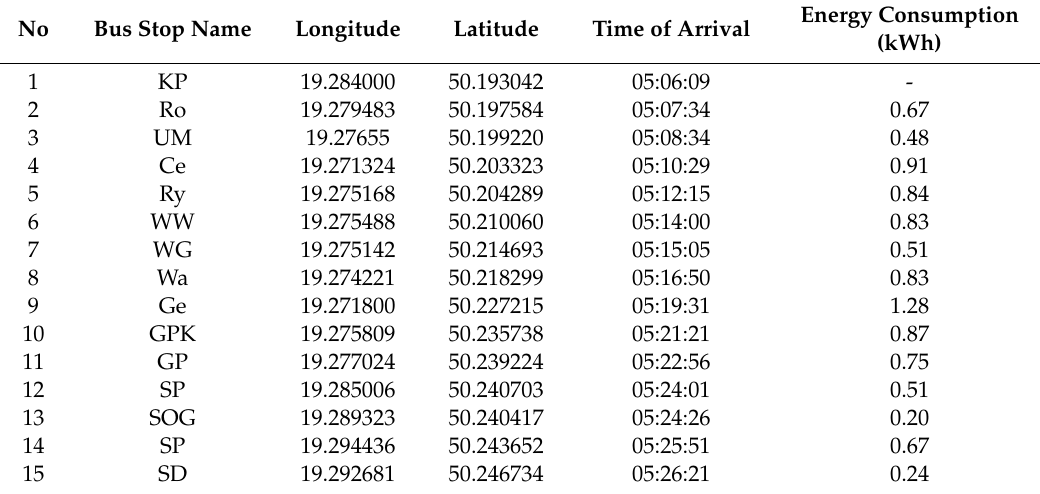
Figure 1. Route of an analysed bus line.